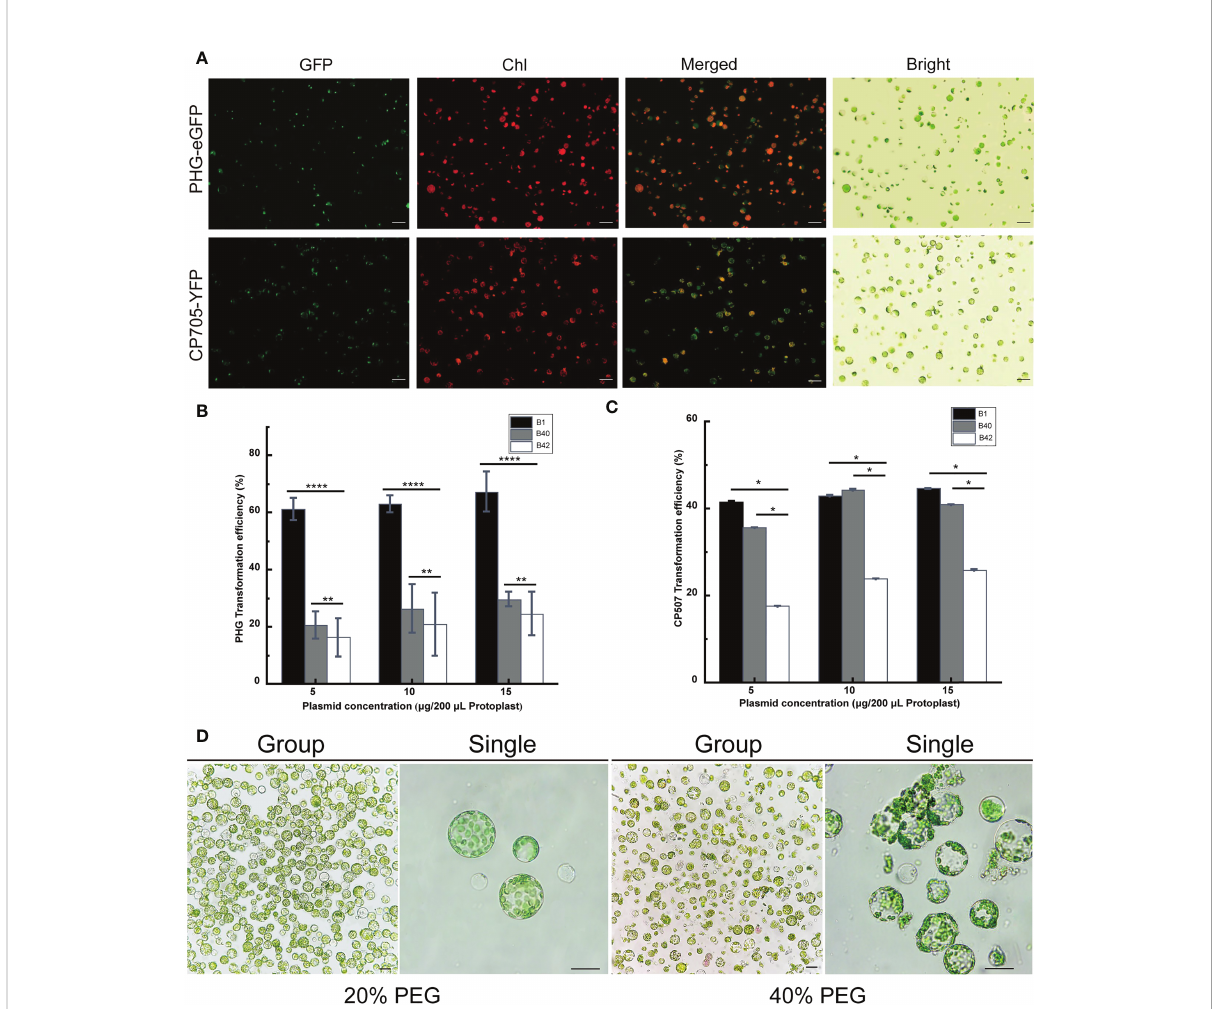
FIGURE 2 Optimization of the transient transformation system for broccoli protoplasts. Transient expression of different constructs in B1 protoplasts. Samples were visualized under a fl uorescence microscope. (A) The 35S::eGFP PHG-eGFP and 35S::YFP CP507-YFP were transiently expressed in B1 cotyledon protoplasts. Merged images of GFP or YFP and chlorophyll auto fl uorescence (Chl) as well as bright fi eld images of protoplasts were shown. Scale bar = 20 m m. (B, C) Comparison of transfection ef fi ciency of 5-15 m g/200 m L protoplasts PHG-eGFP and CP507-YFP plasmids in B1, B40 and B42 cotyledon protoplasts, expressed as the ratio of GFP-positive cells to the total number of protoplasts (n ≥ 100). Data represent the means of 3 values, and error bars show the standard error values; Statistical signi fi cance levels (Student ’ s t-test) are shown: ns, no signi fi cant; * p < 0.05; ** p < 0.01; **** p < 0. 0001. (D) After 20% PEG4000 and 40% PEG4000 induction treatment for 20 min, the protoplasts were incubated in W5 solution for 12 h to observe the protoplast culture by microscopy. Group images and single images were observed under 10× and 40× microscope, respectively. Scale bar = 10 m